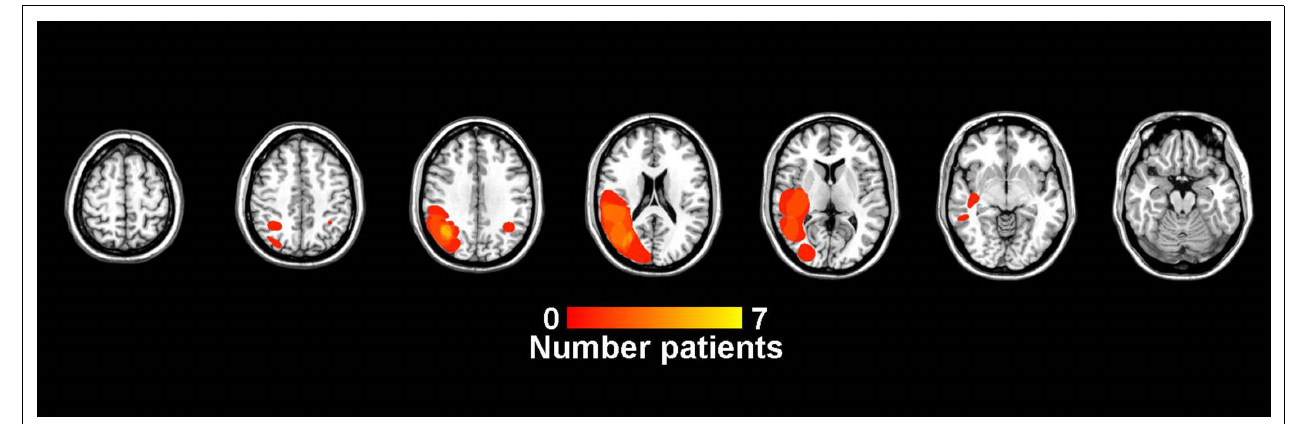
FIGURE 5 | Lesion overlap for patients in the predominantly posterior parietal lesion